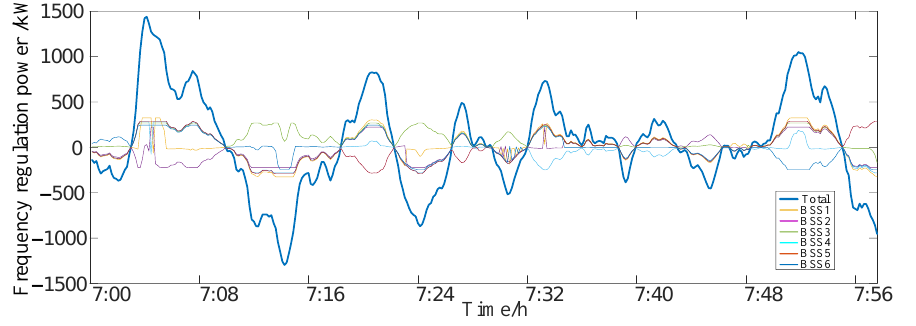
Figure 6. FR power in the 8th period. Table 4. Distribution of battery swap demand from 7:00 to 8:00. Prediction of the Number of Battery Swap When the Battery Swap Demand Arises Station Battery Swap Demand/pc